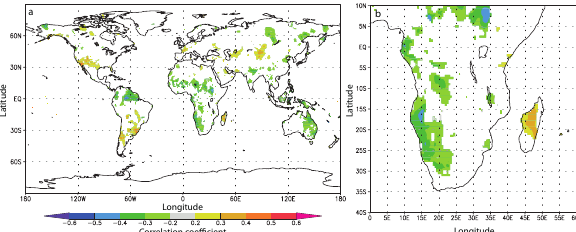
Fig. 9. Spatial correlation of mean annual averages (May to April) of the Pacific Decadal Oscillation (PDO) (Mantua et al., 1997) with global annually averaged (May to April) rainfall data produced by the Climate Research Unit (CRU) at the University of East An- glia (CRU TS3) (Mitchell and Jones, 2005). Correlations are shown over the globe (a) and for central and southern Africa (b) . Colour shading represents confidence of 95% and greater. Red shading in- dicates positive correlations and green negative correlations. Note the positive correlation of rainfall with the PDO over Madagas- car and negative correlation over eastern Australia and the northern Rocky Mountains, North America. Correlations were computed at